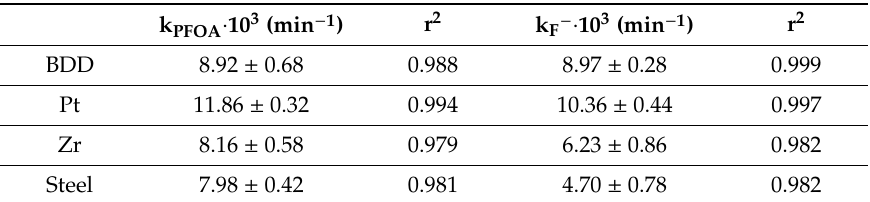
Table 2. PFOA degradation and fluoride release